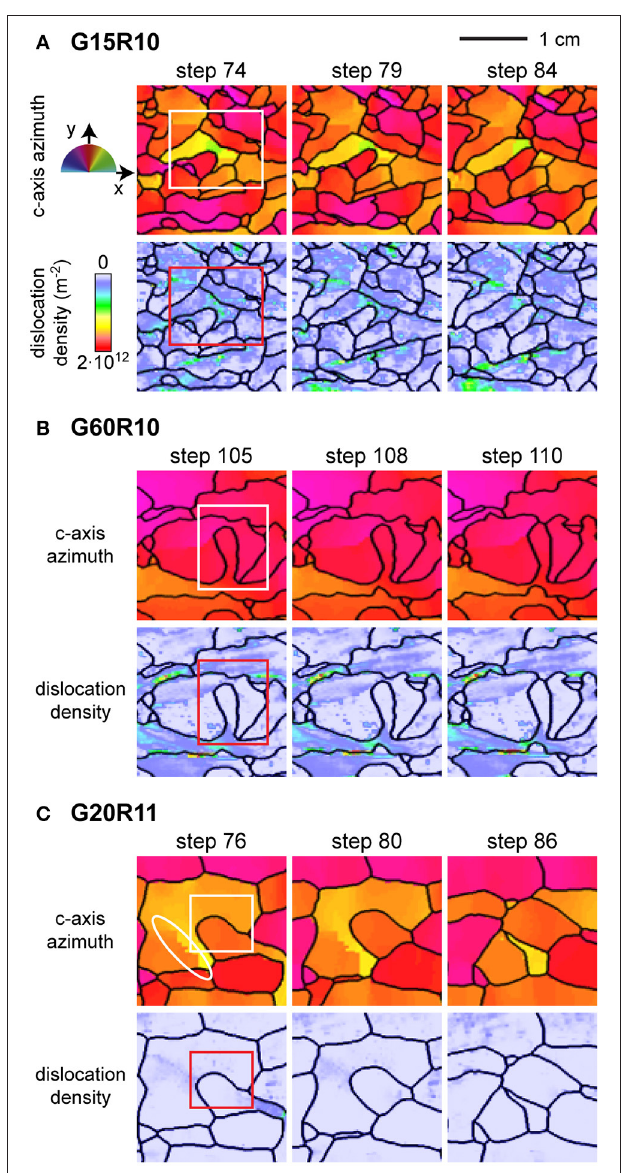
FIGURE 4 | Detail of several examples of grain dissection events observed in the numerical simulations. The images are 1 by 1 cm snapshots and are color coded for c-axis azimuth and dislocation density. The squares indicate rapidly-migrating bulges merging with an opposite grain boundary (grain dissection). The white ellipse shows where a subgrain boundary develops into a high-angle grain boundary by polygonisation. (A) Simulation G15R10. (B) Simulation G60R10. (C) Simulation